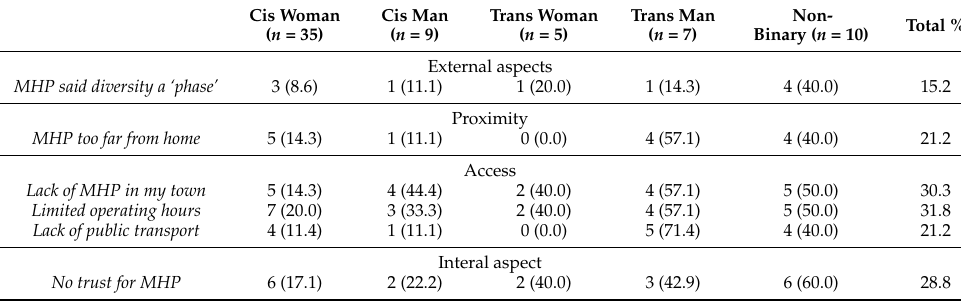
Table 3. Gender and formal help-seeking variables from survey data ( n =